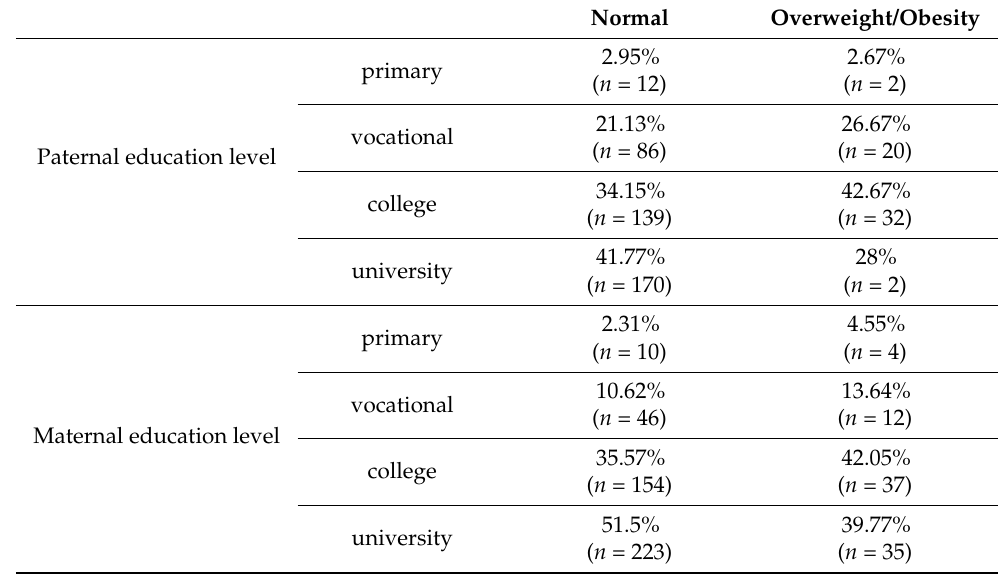
Table 5. Parental education in two weight categories of children (normal and excessive